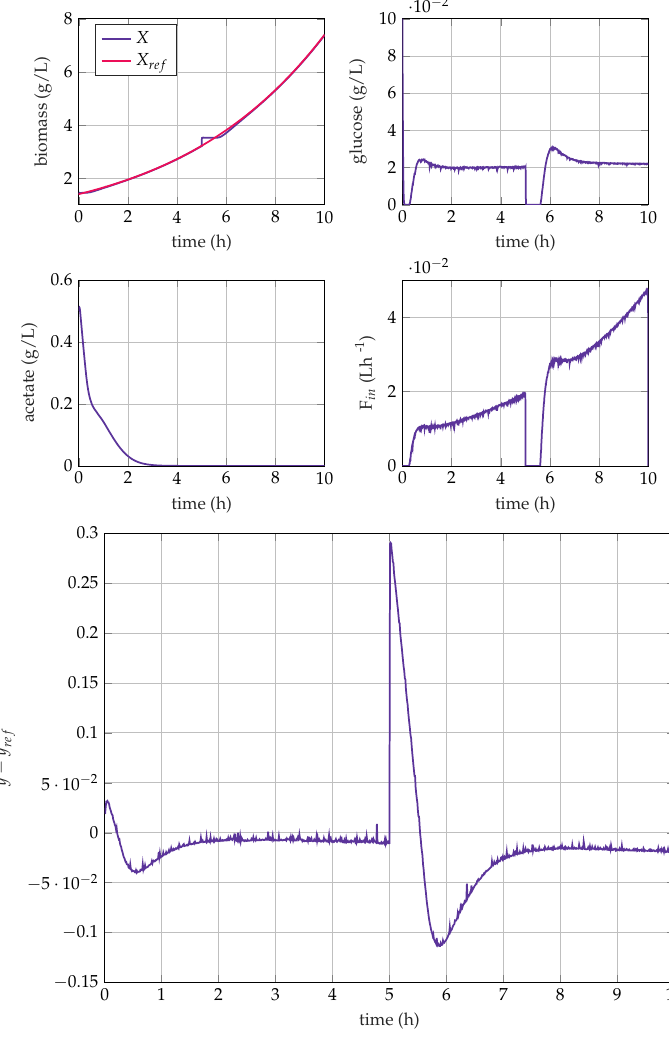
Figure 11. Closed-loop response to a disturbance on the biomass signal at t = 5